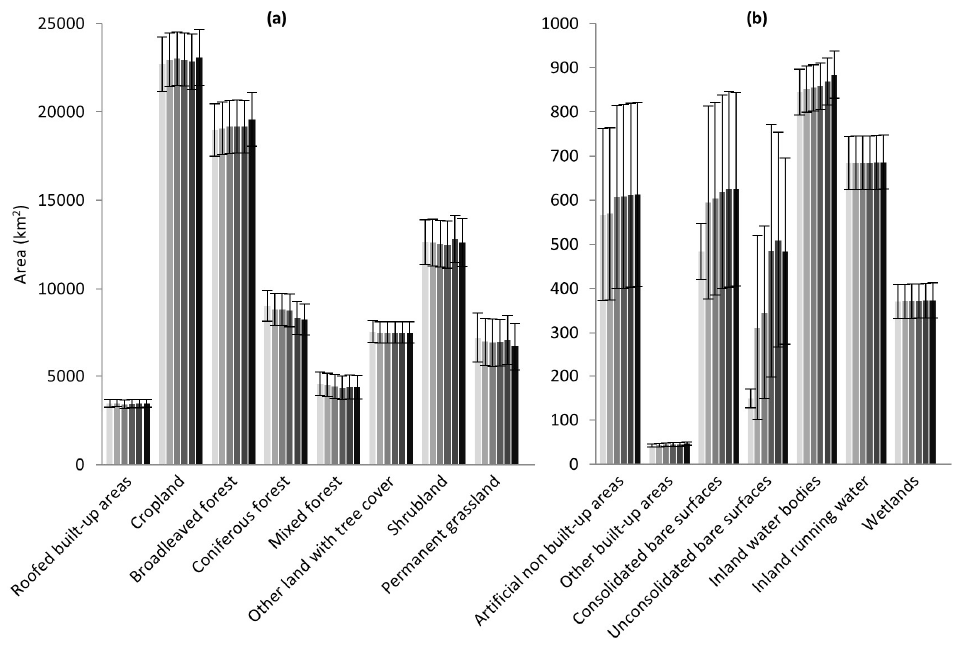
Figure 7. Estimated area of the land cover classes with a 95% confidence interval. Most and least abundant classes are shown separately in ( a , b ) to improve abundant classes are shown separately in ( a ) and ( b ) to improve readability.